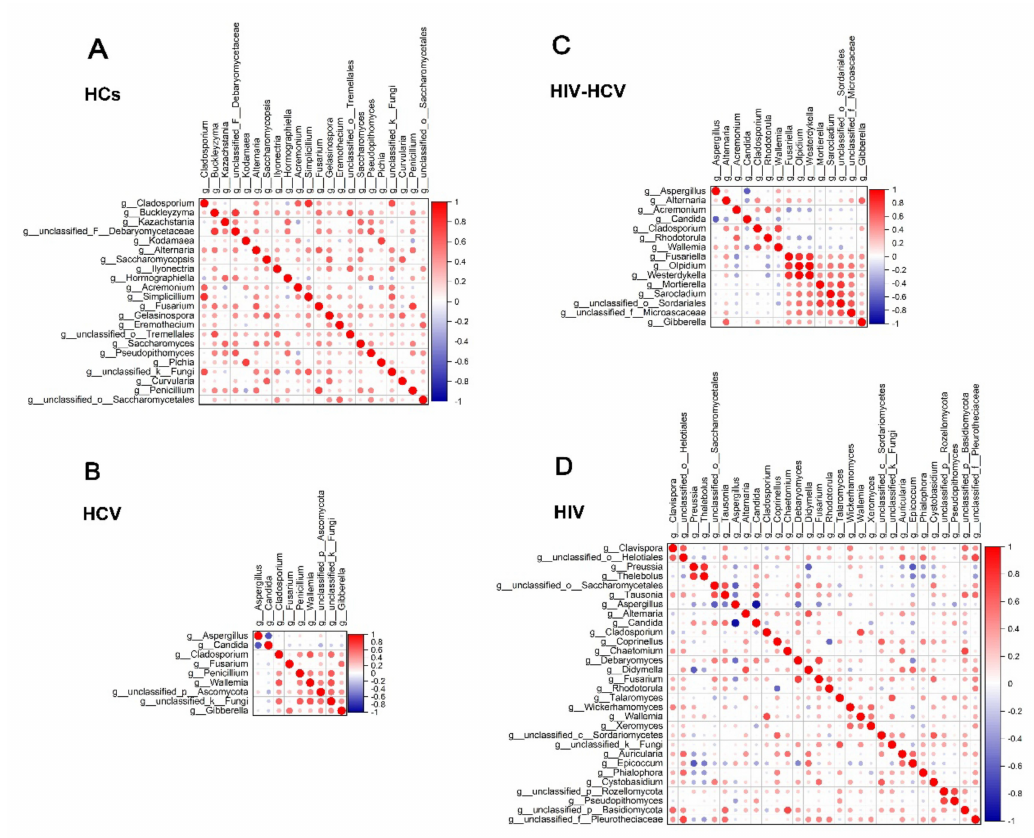
Figure 7. Correlation coefficients of mycobiome abundance in healthy controls ( A ), HCV mono- infected patients ( B ), HIV/HCV co-infected patients ( C ), and HIV mono-infected patients ( D ). Cor- relation of the mycobiome was determined using R statistical computing software (Spearman’s correlation and two-tailed probability of t for each correlation) for the four groups. Red: positive correlation; Blue: negative correlation; diameter of circles represents the absolute value of correlation for each pair of the fungi–fungi matrix. (Spearman rho > 0.6; p -value <